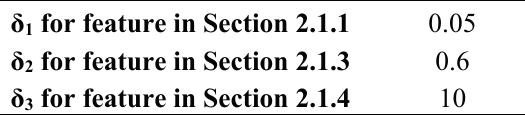
Table 1. Thresholds adopted in the